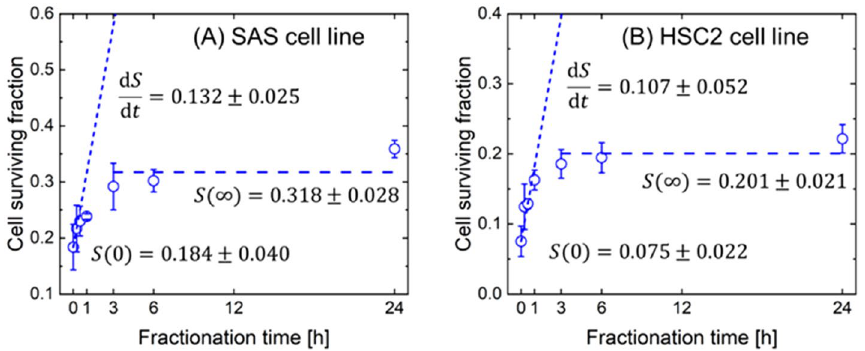
Figure 2. Determination of ( a + c ) values for non-resistant cell lines. ( A ) is cell recovery curve of SAS and ( B ) is that of HSC2. The symbols are shown the experimental cell surviving fraction of fractionated radiations as a function of time intervals (h), while two dotted lines are initial slopes of d S /d τ and S (∞) expressed in Eq. (5), respectively. Using the values described in this figure, the SLDR rates of non-radioresisitant cell lines (SAS, HSC2) were